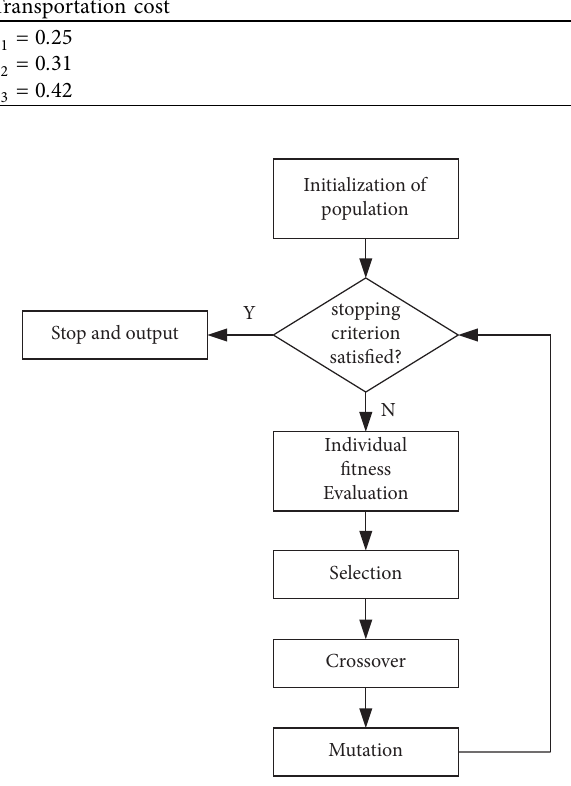
j back to the manufacture.